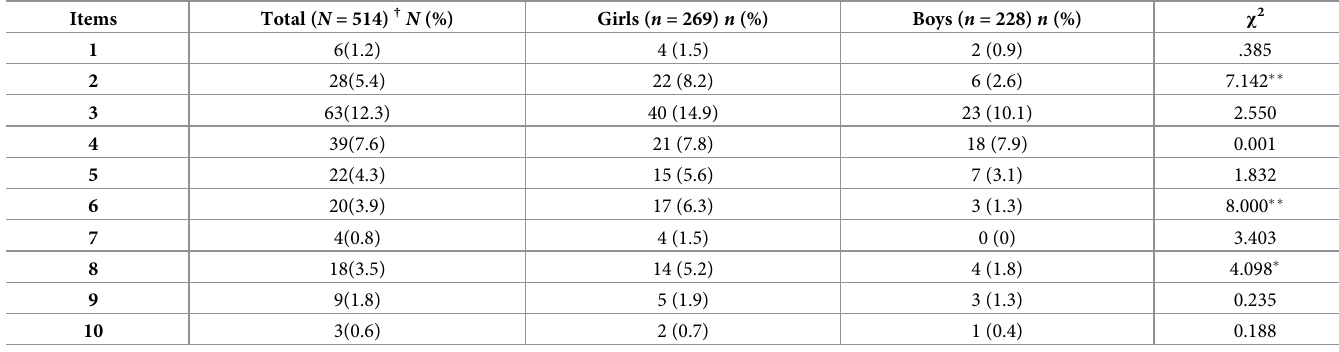
Table 4. Frequencies of the total sample, girls, and boys endorsing the SHSI (N = 514). Items